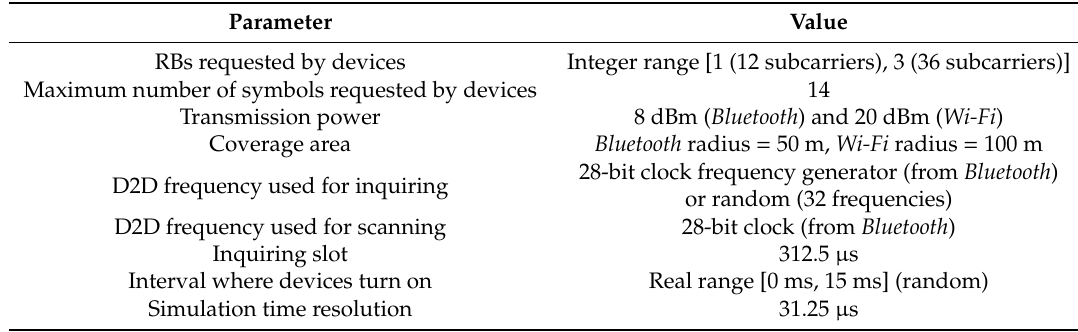
Table 3. Parameters used by the devices in the simulation.